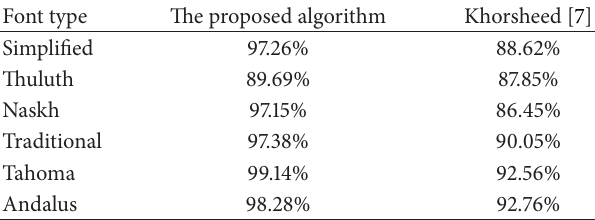
Table 4: Recognition results for each font in the